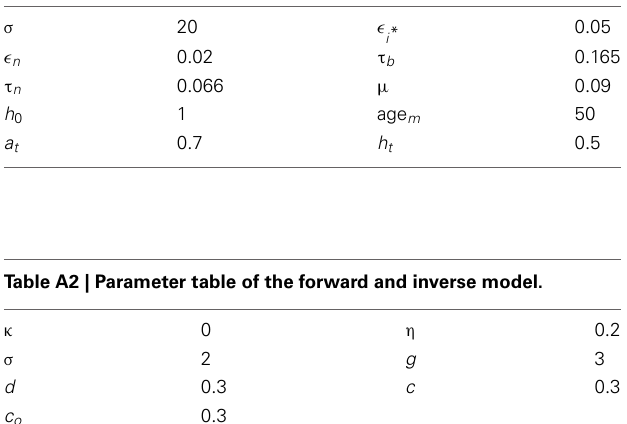
Table A1 | Parameter table of the sensorimotor map building.